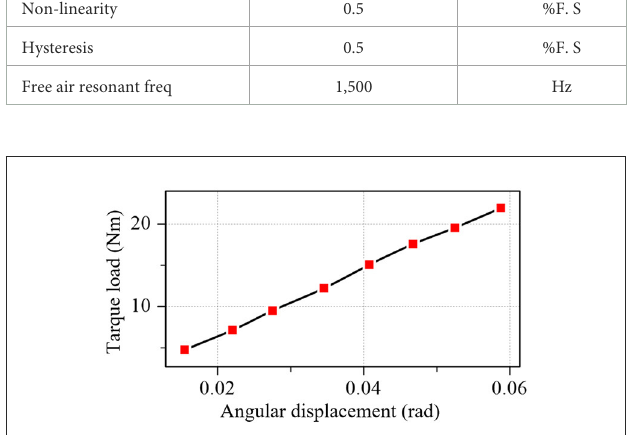
FIGURE10 Test results of the optimal